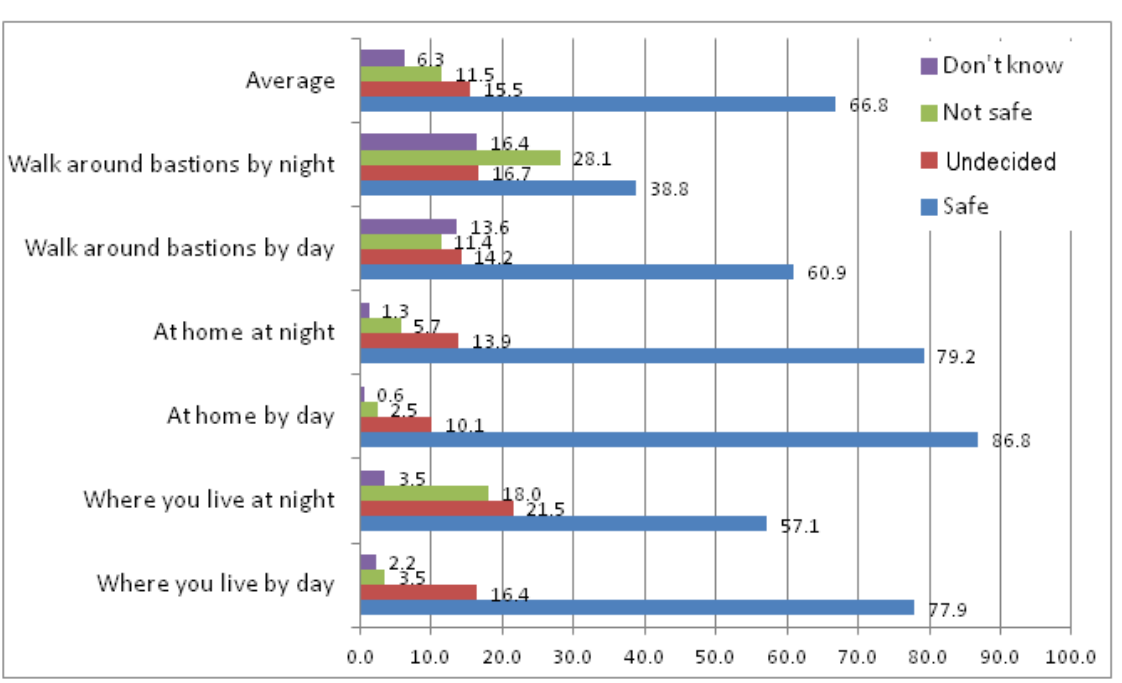
Figure 6. Perception of safety by